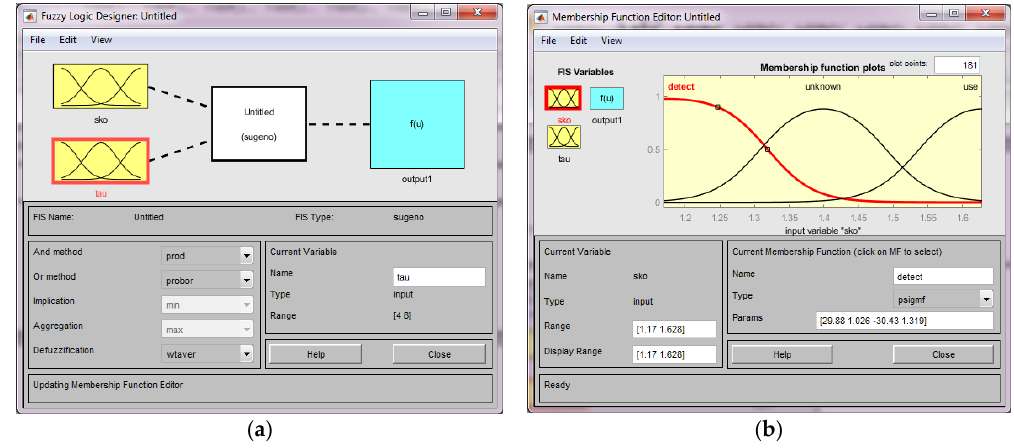
Figure 14. Configurable fuzzy logic: ( a ) Structural diagram; ( b ) Value functions.